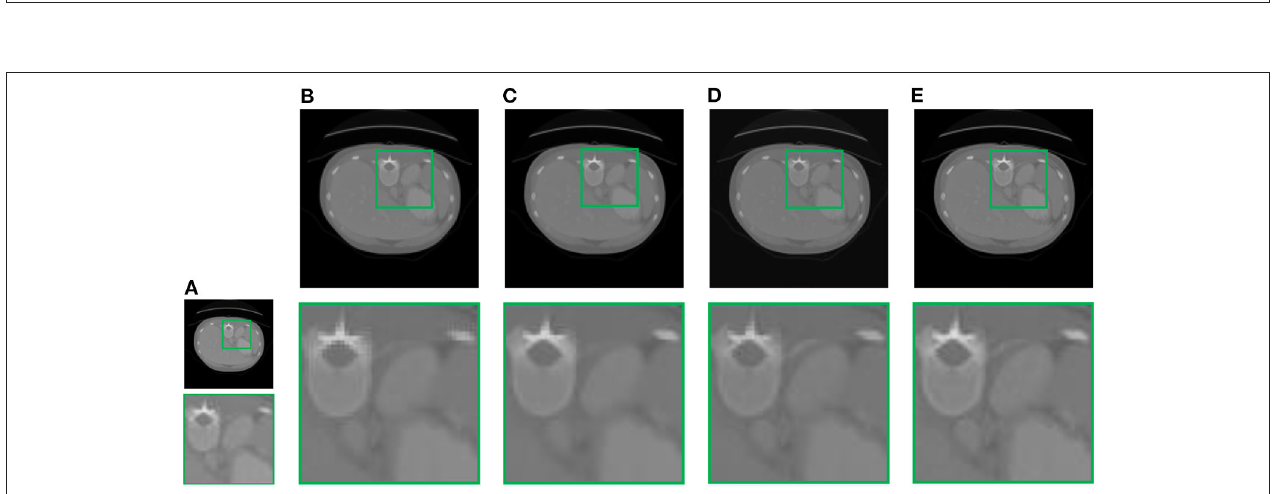
FIGURE 6 | Reconstruction results and corresponding details of contrast-enhanced abdominal CT data from NIH pancreas segmentation database: (A) LR band with downsampling factor 2, (B) NN, (C) LRTV, (D) TF-SISR, (E) NNTDTV.